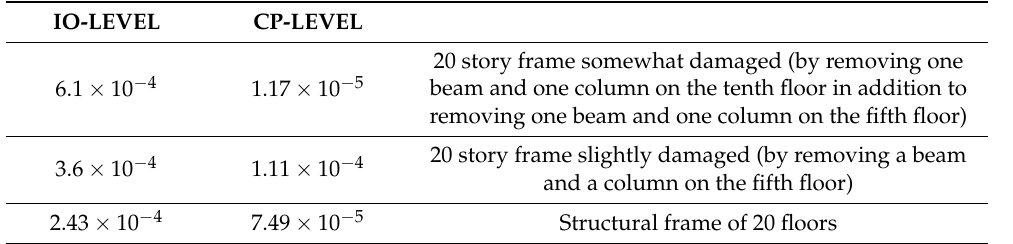
Table 7. Mean annual frequency for three